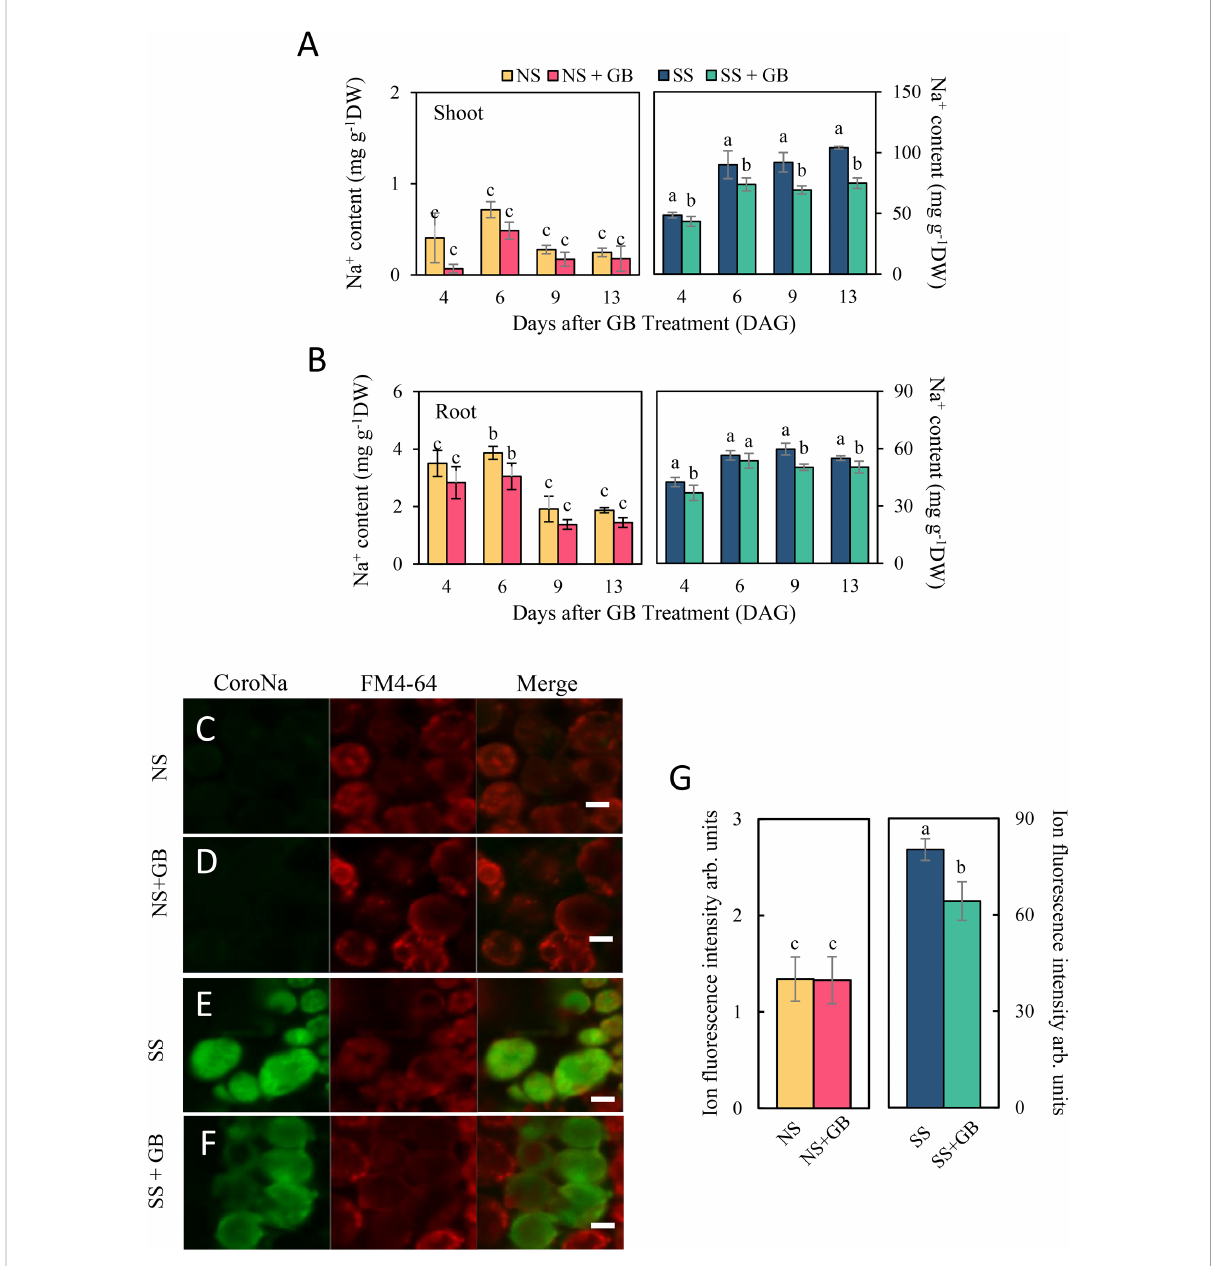
FIGURE 3 Effects of GB on maize plant and cellular Na + accumulation under non-stressed (NS) and salinity-stressed (SS) conditions. (A) Concentration of Na + in the shoots and (B) roots. The values indicate the mean, while the vertical error bars indicate the standard deviation (n = 5). The different letters in each panel represent signi fi cant differences determined with Fisher ’ s protected LSD test at P < 0.05. (C-F) depicted effects of GB on the fl uorescence intensity of cellular Na + after 3 days of treatment with NaCl. Na + was stained using CoroNa ™ Green, while the cell membrane was stained with FM4-64. (C) control under NS condition, (D) GB-treated group under NS condition, (E) control under SS condition, and (F) GB- treated group under SS condition. White horizontal bar = 10 m m. (G) Statistic of fl uorescence intensity of cellular Na + . The values indicate the mean, while the vertical error bars indicate the standard deviation (n = 50). The different letters on the bar represent signi fi cant differences determined with Fisher ’ s protected LSD test at P <